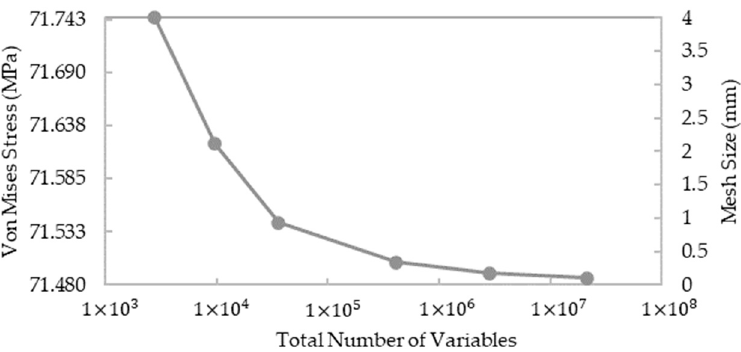
Figure A1. Mesh convergence for local stress values.